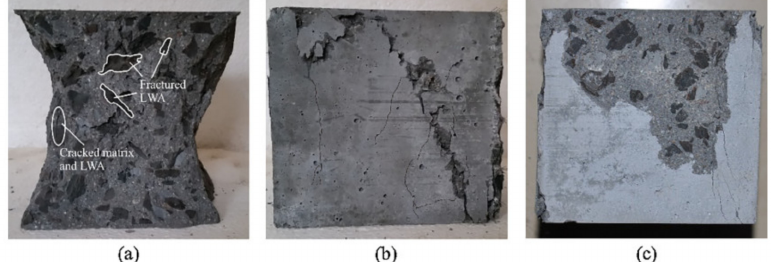
Figure11. Compressionfailuremechanisms: ( a )plainLWACspecimens, ( b )steelfiberLWACspecimens, ( c ) carbon fiber LWAC specimens [82], with copyright permission from